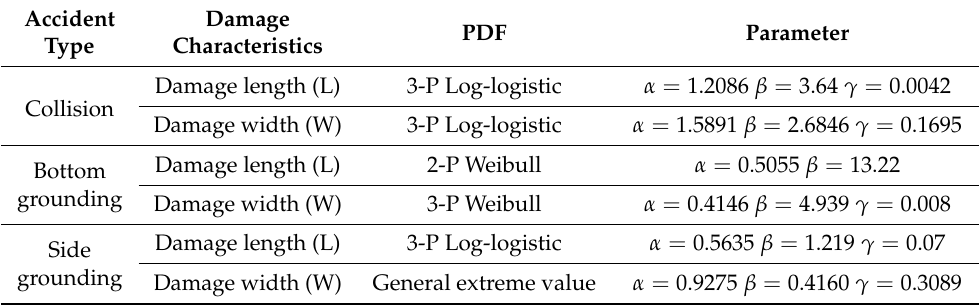
Table 3. The probability distribution of breach extents for collision, bottom, and side